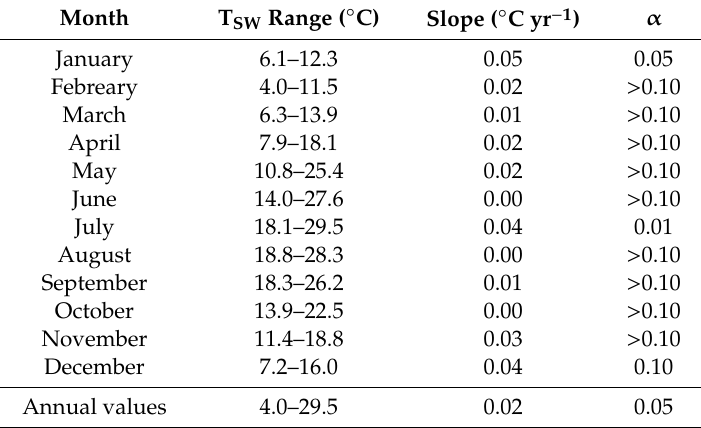
Table 2. Range of variation of subsurface seawater temperature (T SW ; ◦ C) and trends of monthly (annual) mean values at Trieste in 1986–2015. The significance of temperature trends ( α ) and their slope ( ◦ C yr − 1 ) are calculated with MK and S tests,